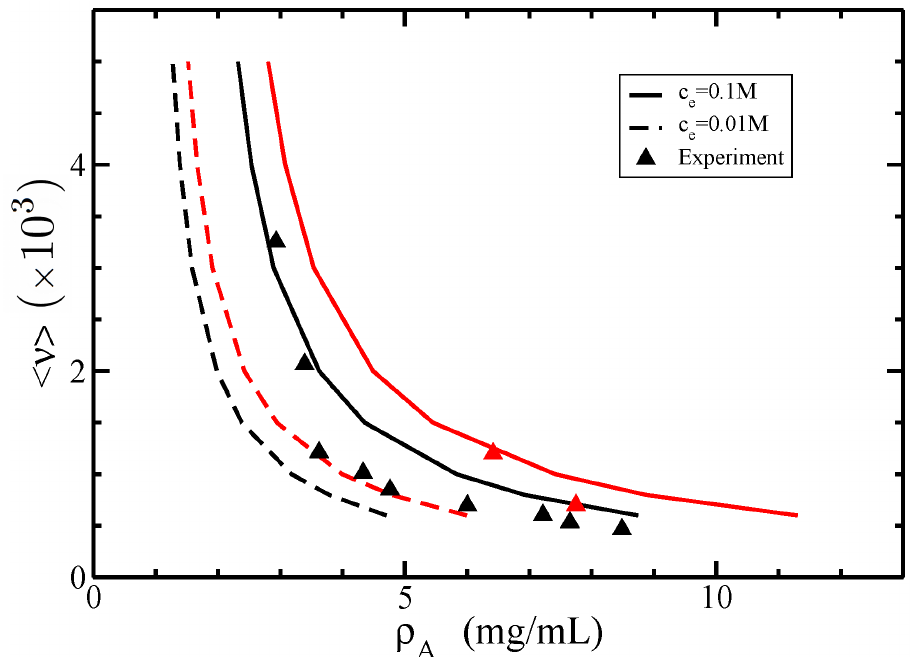
Figure 11. The isotropic–nematic phase diagram in terms of coexisting densities of actin ρ A for different average lengths of filaments < ν > and two values of electrolyte concentrations c e = 0.01M (dashed lines) and c e = 0.1M (solid lines). The persistence length is P = 18 µ m, and the normalized standard deviation σ = 0.5. The experimental data (triangles) were retrieved from [26]. The coexisting isotropic and nematic densities are plotted in black and red colors, respectively.